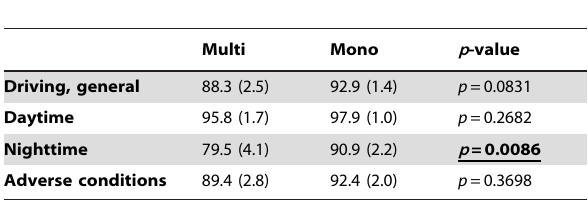
Table 3. Detailed summary of driving scores according